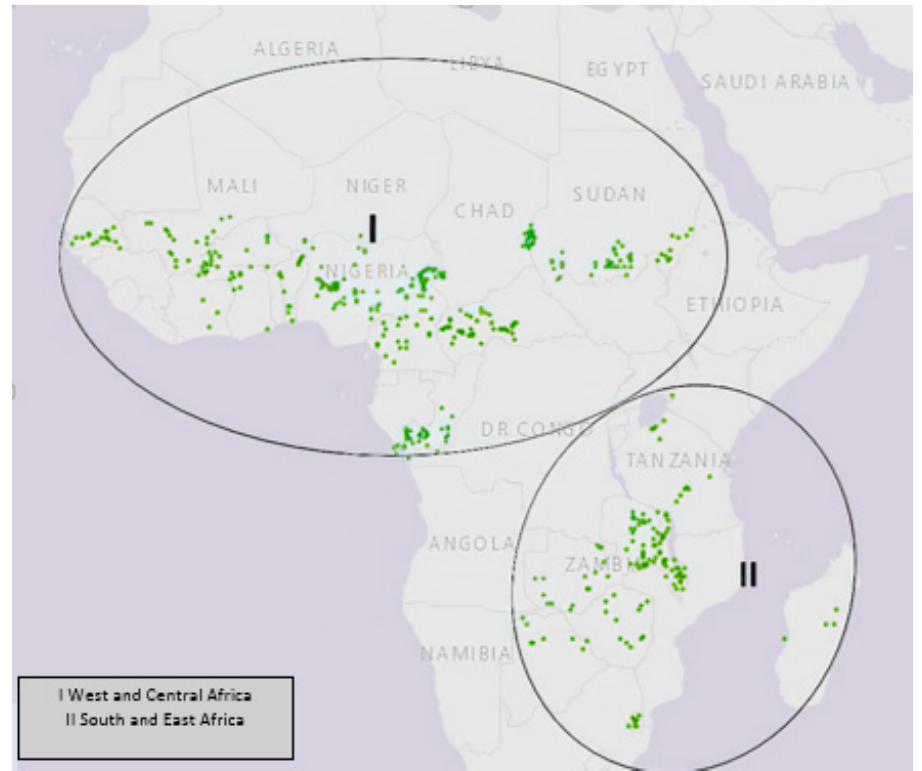
Figure 1. Centers of domestication of bambara groundnut accessions in IITA-GRC. Source: https://www.genesys-pgr.org/ accessed on 3 January 2022. Table 1. Plant genetic resources of bambara groundnut held in various